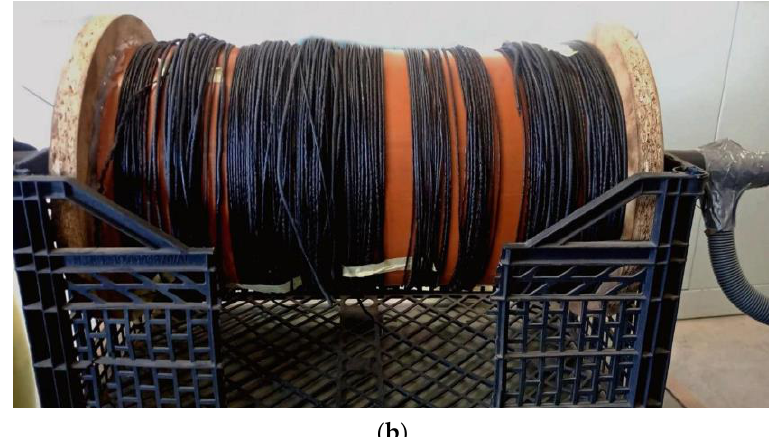
Figure 3. ( a ) Shore hardness meter type D. ( b ) Bobbin with valorised material.